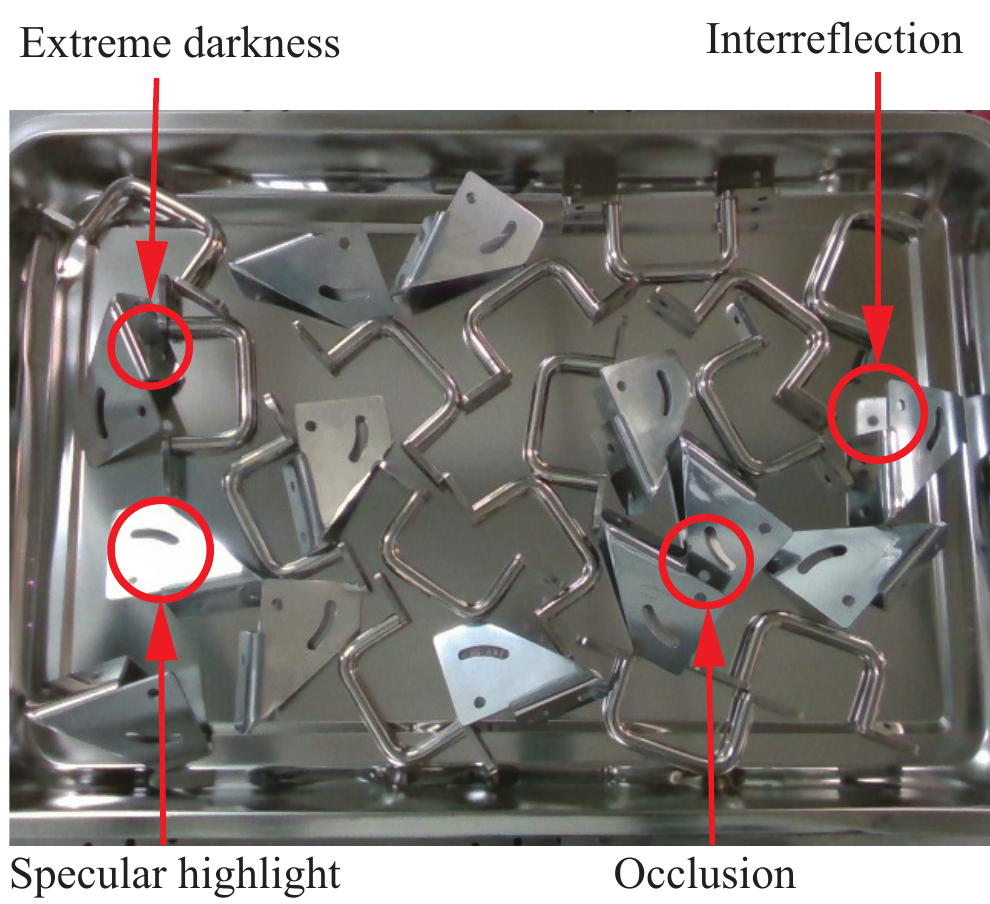
Figure 1. Challenges of Pose Estimation for Shiny Metal